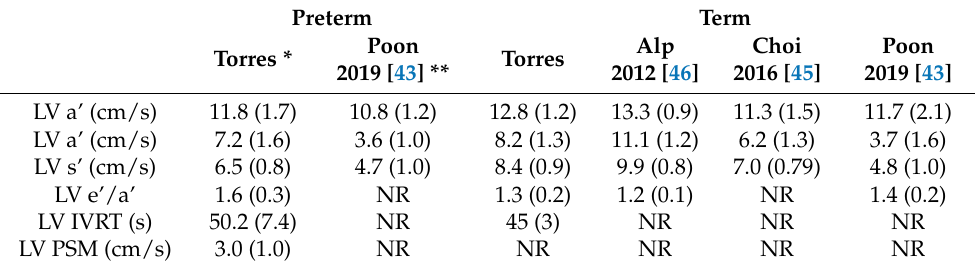
Table 6. Current literature on tissue Doppler velocities at one year of age.